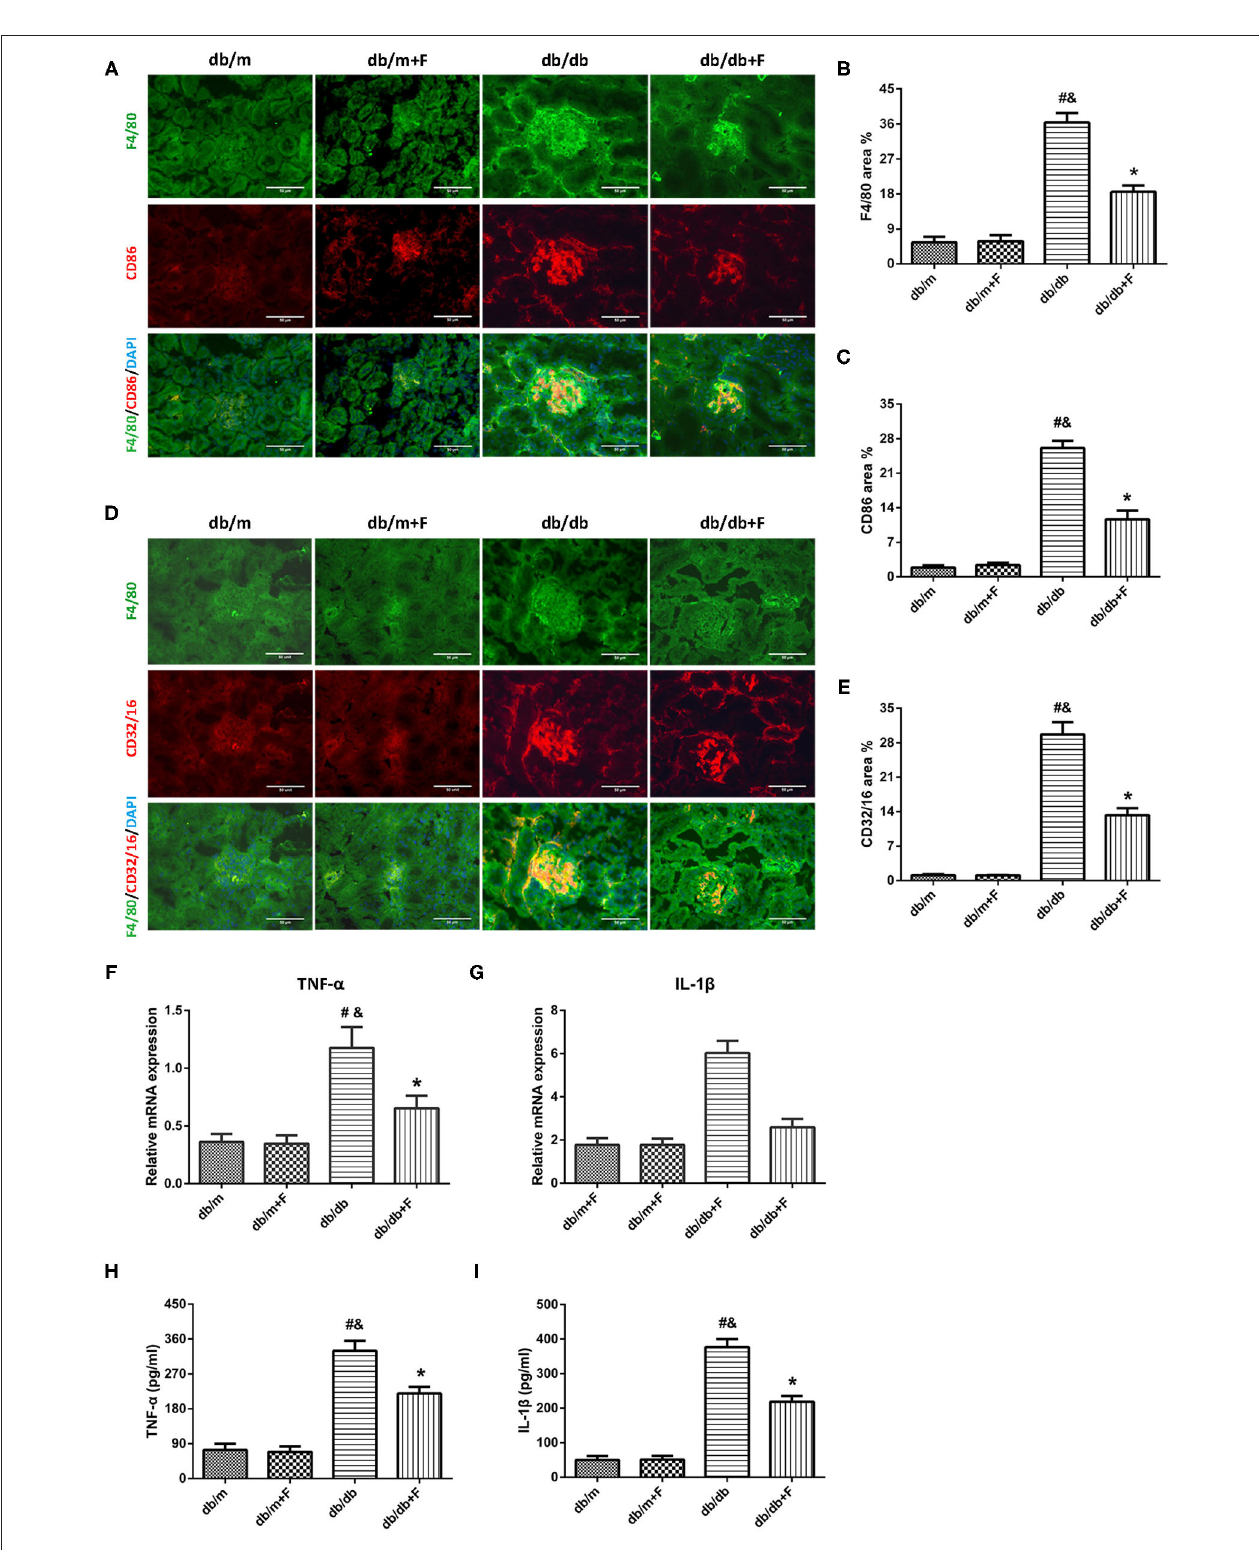
FIGURE 7 | M1 macrophages in mouse kidneys and serum. (A–C) Representative photographs and quantification of co-staining of F4/80 and CD86 in mouse kidneys. (D,E) Representative photographs and quantification of co-staining of F4/80 and CD32/16 in mouse kidneys. (F,G) MRNA expression analyses of tumor necrosis factor (TNF)- α (F) and interleukin (IL)-1 β (G) by quantitative reverse transcriptase PCR (RT-PCR). (H,I) Serum TNF- α (H) and interleukin (IL)-1 β (I) . n = 6